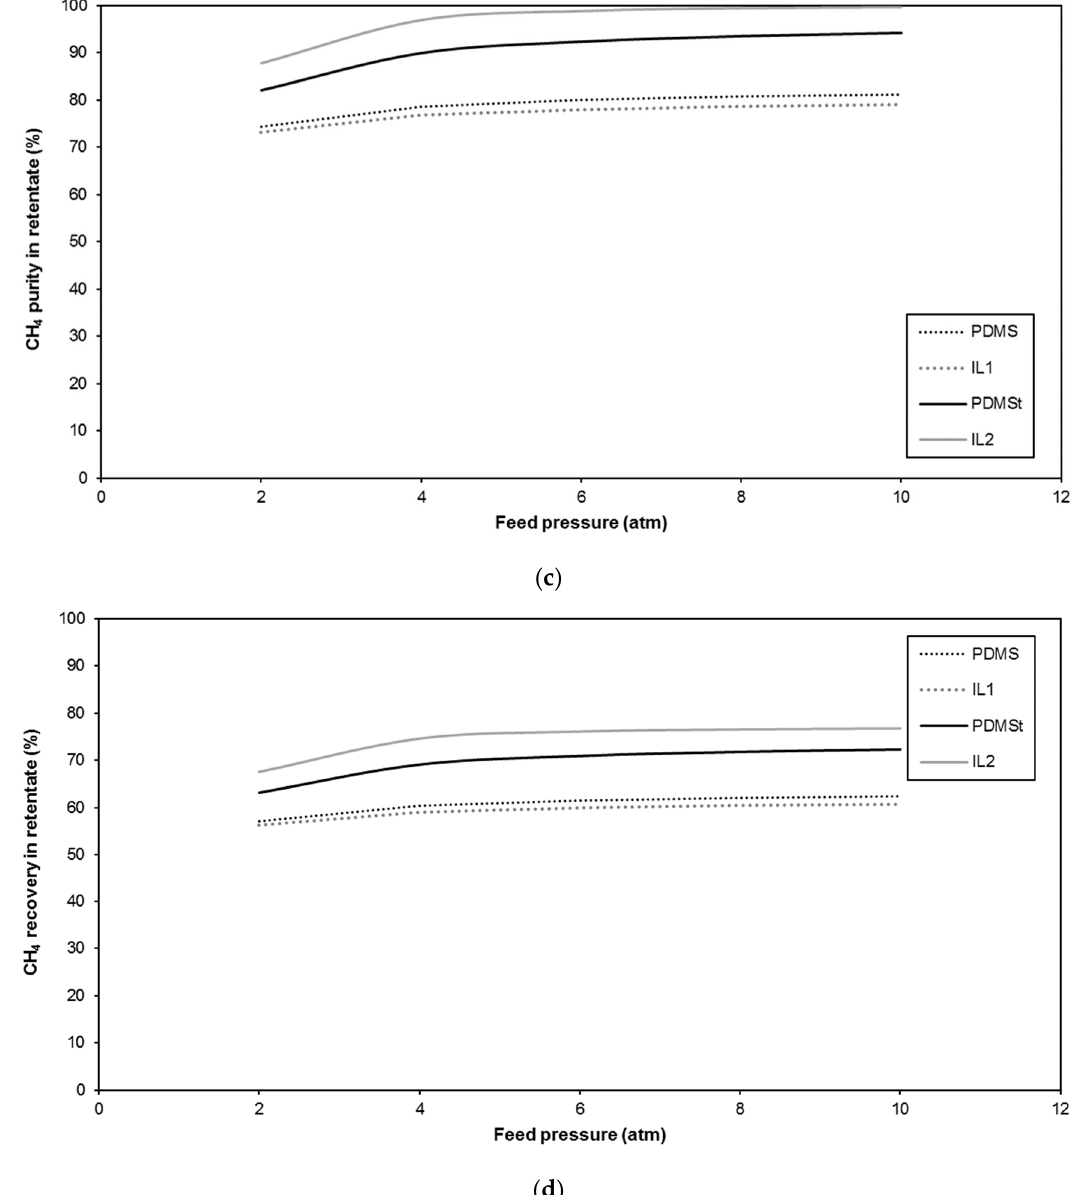
Figure 4. Influence of the feed pressure on ( a ) CO 2 purity, ( b ) CO 2 recovery, ( c ) CH 4 purity and ( d ) CH 4 recovery for the different membranes (P Q = 1 atm, stage cut = 0.5, CO 2 /CH 4 feed composition = 0.35/0.65).